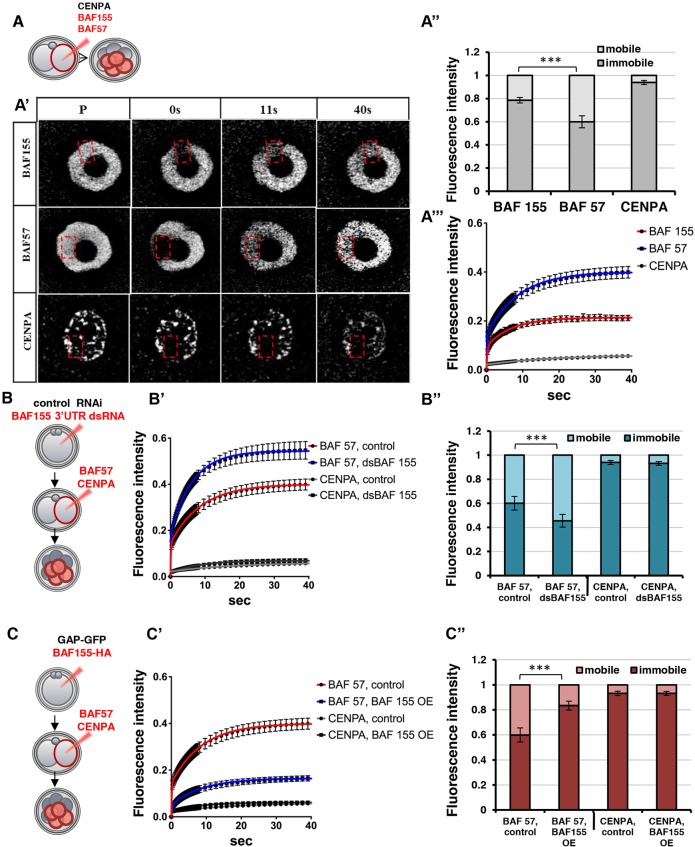
The mobility of BAF57 is dependent on the level of BAF155 expression. (A) The live kinetics of BAF155, BAF57 and CENPA proteins tagged with mCherry were measured at the 8-cell stage. (A′) Recovery kinetics were estimated by measuring fluorescence intensity (within the boxed region) prior to photobleaching (P) and during 40 s after photobleaching. (A″) The immobile pool was significantly greater for BAF155 (78.61±2.4%) than BAF57 (59.97±5.0%); the immobile fraction of CENPA was the highest (93.9±1.7%). (A‴) Greater mobility of BAF57 than of BAF155 or CENPA was detected by greater FRAP recovery. (B) The kinetics of BAF57 and CENPA measured at the 8-cell stage of embryos zygotically depleted with dsBAF155. (B′) Recovery of BAF57 was increased in dsBAF155 embryos compared with the controls, whereas CENPA mobility was unaffected. (B″) The immobile fraction of BAF57 in dsBAF155 embryos was reduced, but remained unaffected for CENPA. (C) Kinetics of BAF57 and CENPA estimated at the 8-cell stage of embryos injected with BAF155-HA. (C′) The recovery of BAF57 was reduced in BAF155 OE embryos compared with the control, whereas in CENPA embryos the rate was unchanged. (C″) The immobile fraction of BAF57 was significantly increased in BAF155 OE (83.4±3.6%) compared with control (60±5.6%), whereas CENPA was unaffected. Error bars represent s.e.m. ***P<0.001, F-test.